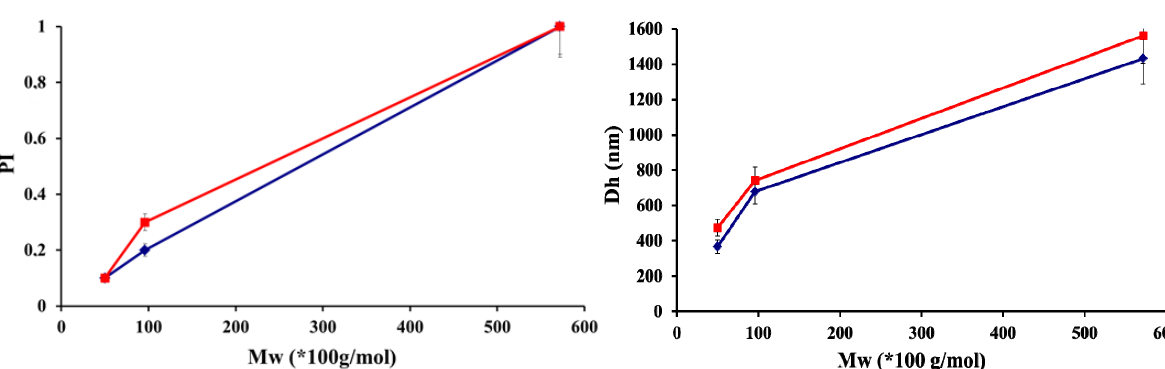
Figure 3. Influence of hyaluronic acid molar masses on sizes and polydispersities (PI) of polyelectrolyte complex particles for chitosan with DA 5% Mw = 100 × 10 3 g/mol (  ) and DA 48% Mw = 130 × 10 3 g/mol (  ), at a charge ratio R = 1.5 and made in water. Datas are the average of three independent experiments ± standard deviation.